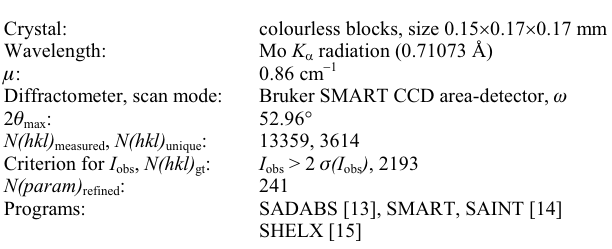
Table 1. Data collection and handling.